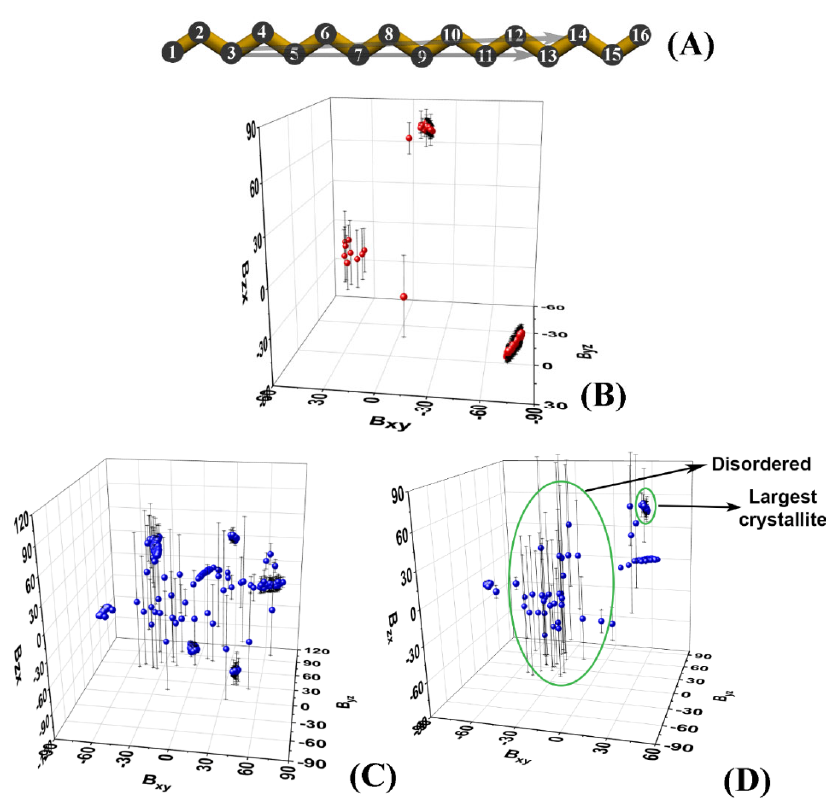
Figure 2. ( A ) Carbon skeleton of hexadecane with numbering of the atoms; the two arrows denote the vectors C 3 C 13 and C 3 C 14 used for the analyses in this paper; 3D plots of the slopes of the vectors C 3 C 14 averaged over the last 50 ns of the MD trajectories in ( B ) bulk HEX simulated at 278 K, ( C ) HEX/Surf/water simulated at 278 K, and ( D ) HEX/Surf/water simulated at 289